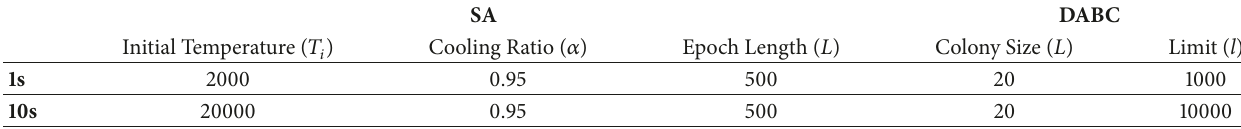
Table 1: Parameters of SA and